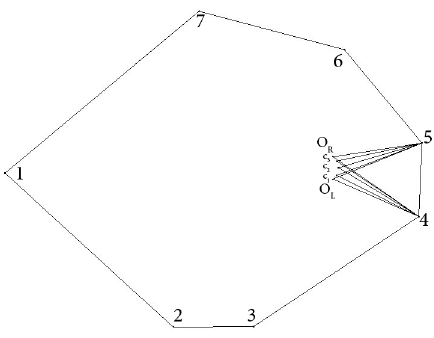
Figure 4. Scheme of the geodetic network Five marks are fixed on the facade of the building of the old church. Their coordinates were measured with a tacheometer from the two points (Figure 5).